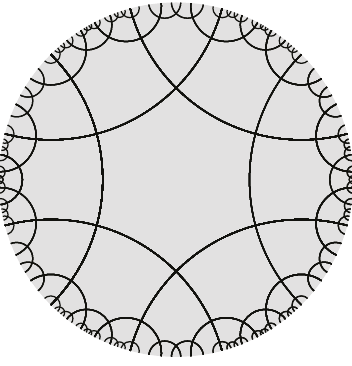
Figure 24 . The hexagonal tiling f 6 ; 4 g